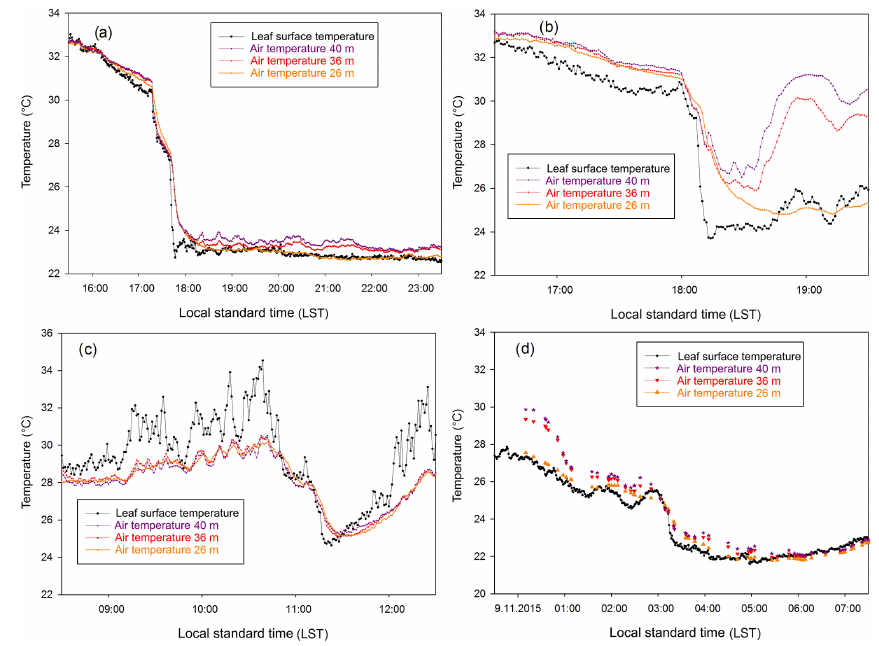
Figure 5. The same as in Fig. 2 but for air and leaf surface